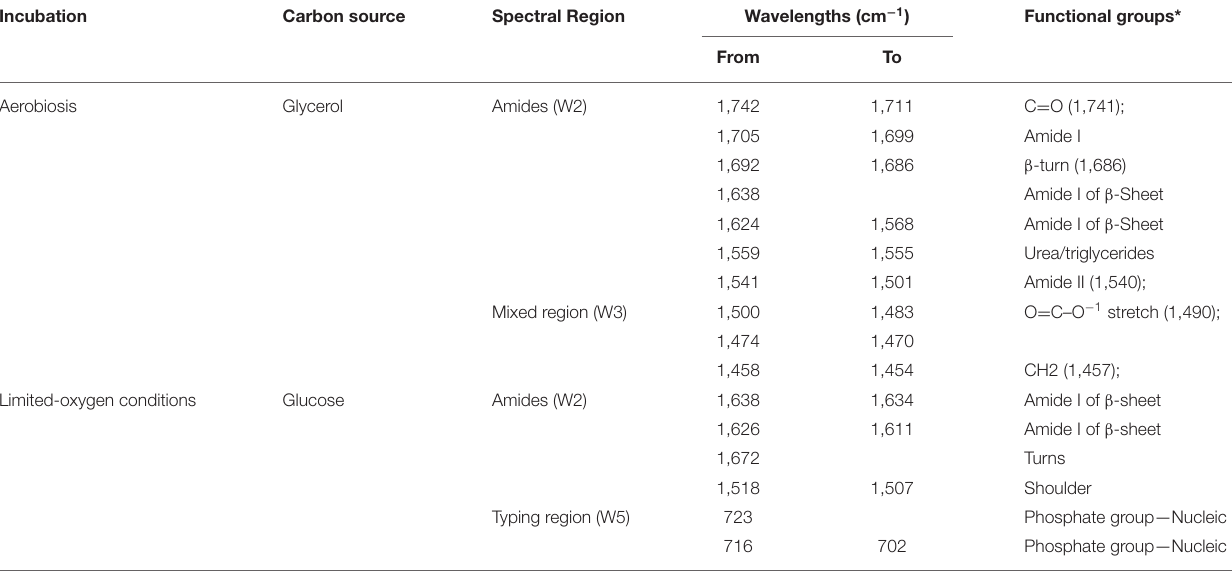
TABLE 2 | Constantly patterns of significant different wavelengths ( p < 0.01) throughout stationary growth of S. cerevisiae C1 in glucose and glycerol under limited-oxygen and aerobic conditions,